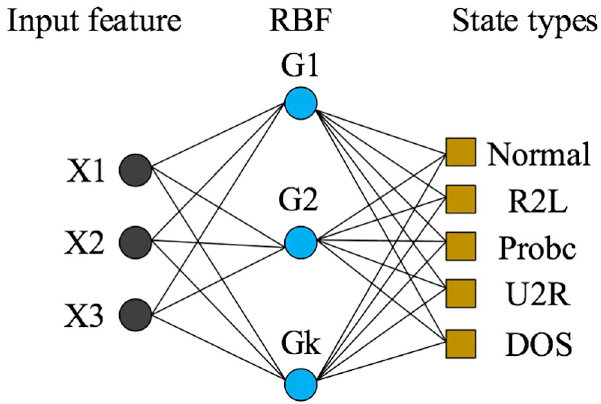
Fig 2. Schematic diagram of the RBF neural network